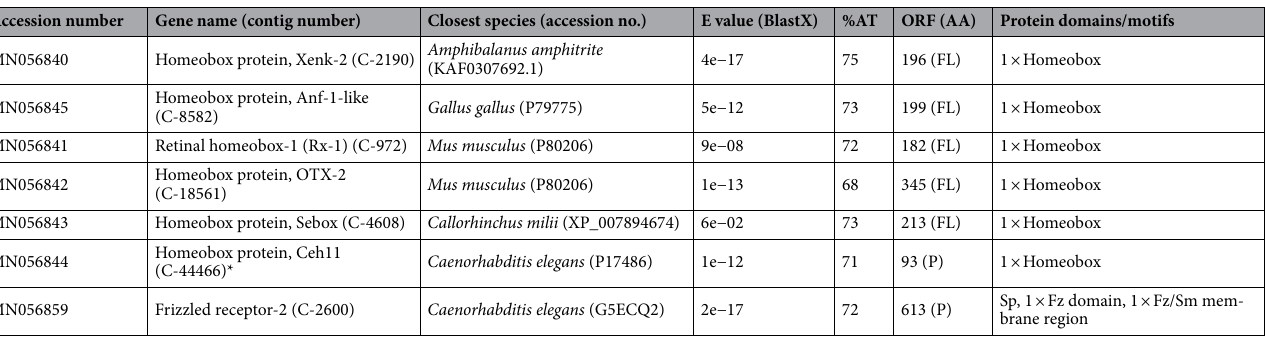
Table 2. Predicted developmental genes in T. bryosalmonae with closest manually annotated sequence by species given alongside predicted protein domains, namely; signal peptide (SP), frizzled (Fz) and smoothened